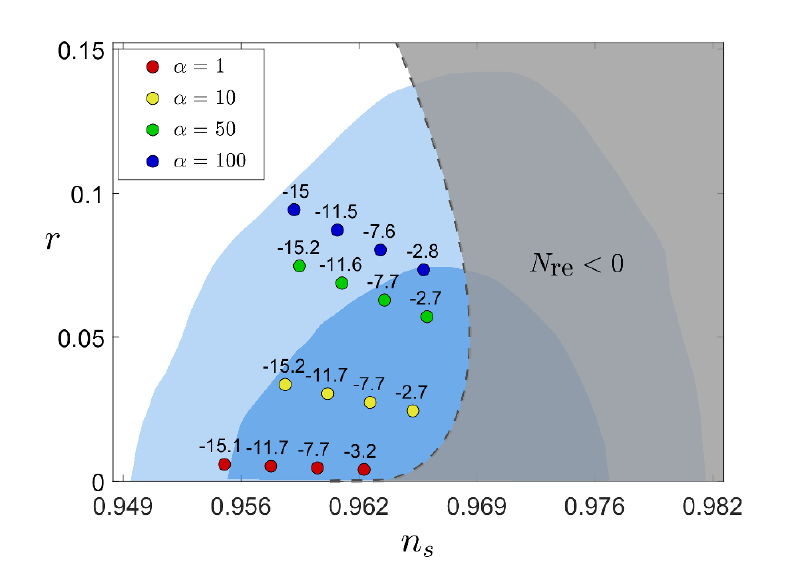
Figure 11. The same as (cid:12)gure 6, but for the interaction h(cid:30)(cid:31) 3 = 3!. The numbers over the disks denote log h computed using eq. 10